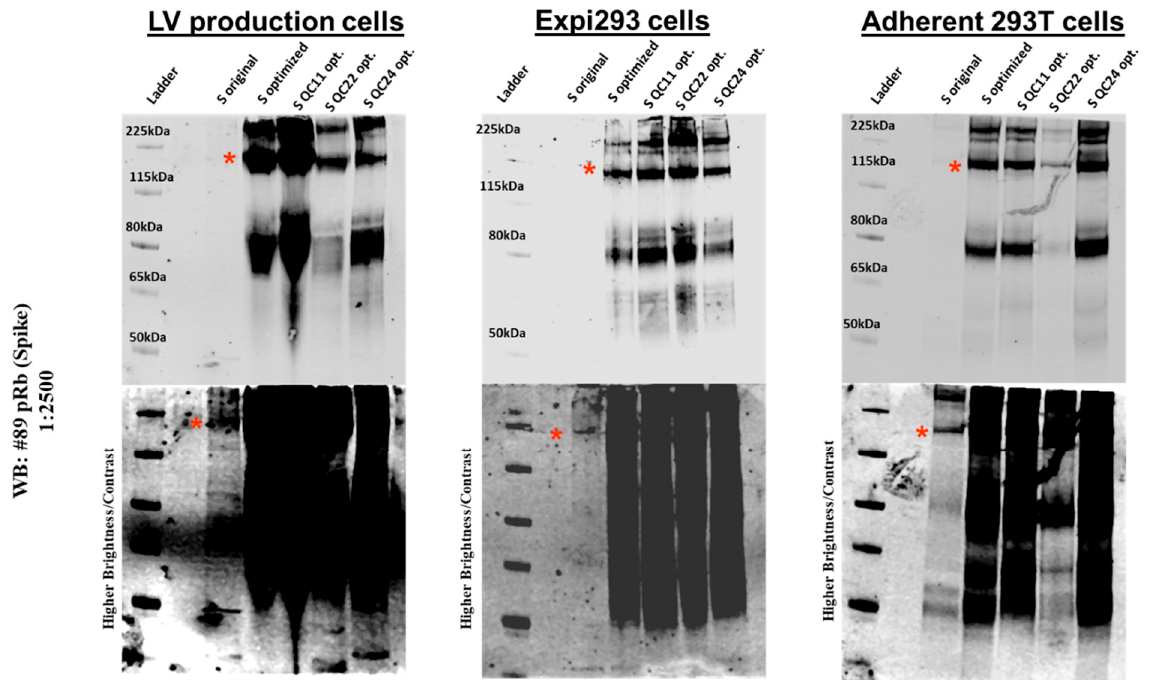
Figure 5. Expression of S protein in pseudovirions expressing original and codon-optimized S proteins. Pseudovirions were produced in LV production cells, Expi293 cells, and adherent HEK293T cells. Upper panels were imaged at normal gain, while lower panels were imaged at higher gain to visualize original S protein expression (S original). Red asterisk indicates spike protein band.